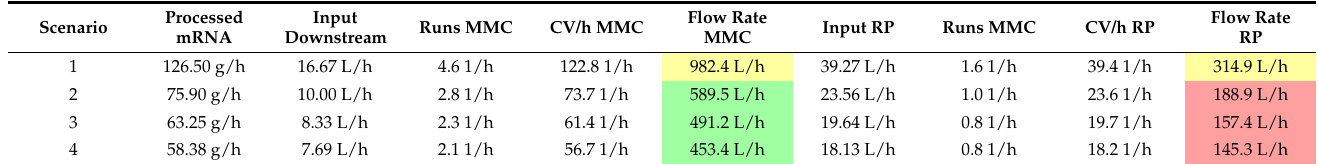
Table 2. Resulting flow rates for MMC and RP for an 8 L monolith. Green: within working velocity, yellow: at limit of working velocity, red: outside of recommended working range.